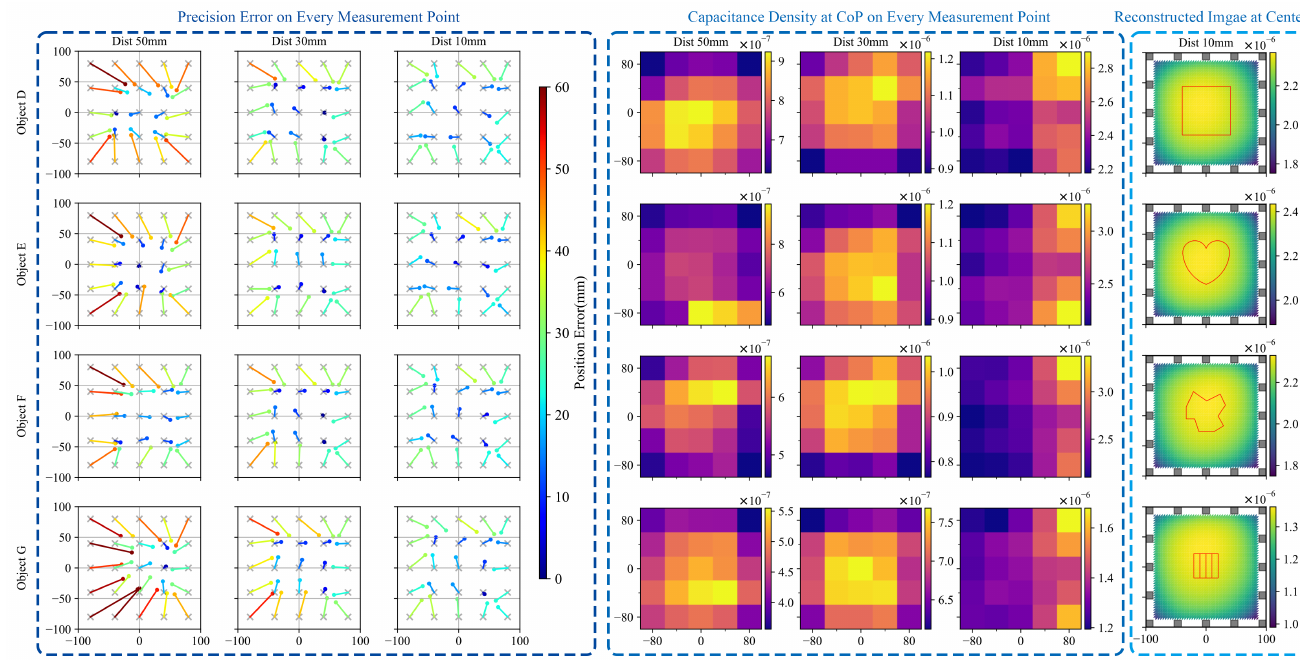
Figure 10. Sensor performance information on a reference object (object D) and three non-square object (objects E, F, and G). The first three columns present the position error of each measurement. The points and gray crosses represent the reconstructed CoPs and the ground truths, respectively. The columns in the middle demonstrate the reconstructed capacitance density value at CoP of each measurement. The reconstructed image is displayed in the last column. Inside the image, the object was hovering 10 mm above the central point of the sensor. Units of all graphs is in millimeter mm and units for capacitance density value is F/mm 2 .